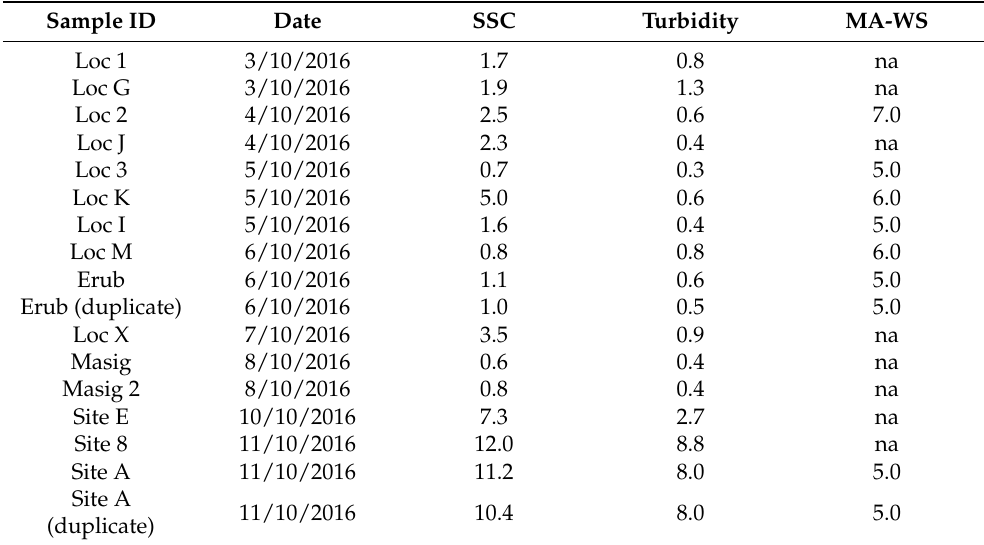
Figure A2. Map showing the locations of sampling sites ( a ) October 2016, ( b ) June 2018 ([26,42], modified). The background satellite image is from Google Earth. Table A1. Water quality measured at the survey sites in October 2016 and June 2018 and correspond- ing MA-WS colour class (MA-WS, na = no data or